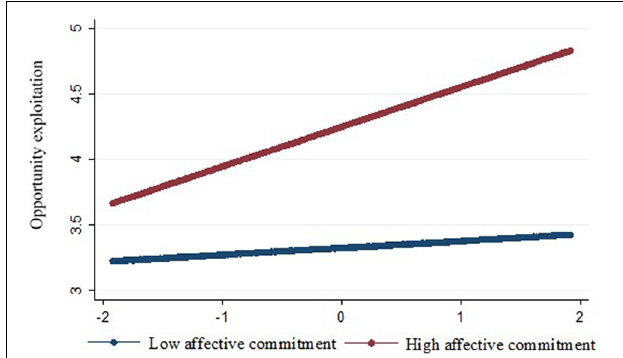
FIGURE 2 | Interaction of flexibility and founder affective commitment on opportunity